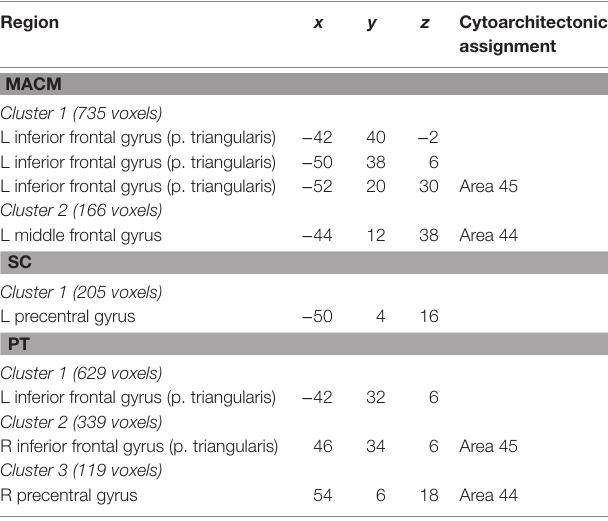
TaBle 4 | specifically absent connectivity of iFs